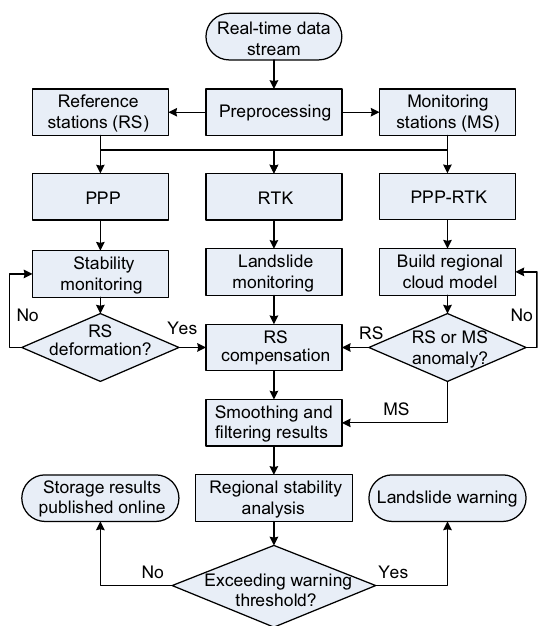
Fig. 5 Processing steps of a combined PPP/RTK/PPP-RTK monitoring technique for landslide